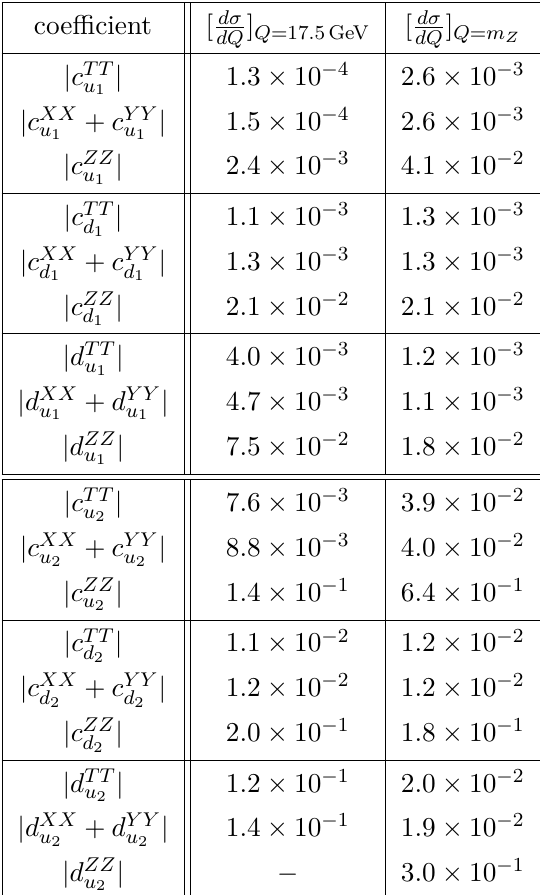
Table 1 . Bounds on the time-independent coefficients in the Sun-centered frame and in the ( c u , c d , d u ) basis for Q = m Z and Q = 17 . 5 GeV. The bound on d ZZ i i i Q = m Z and has been